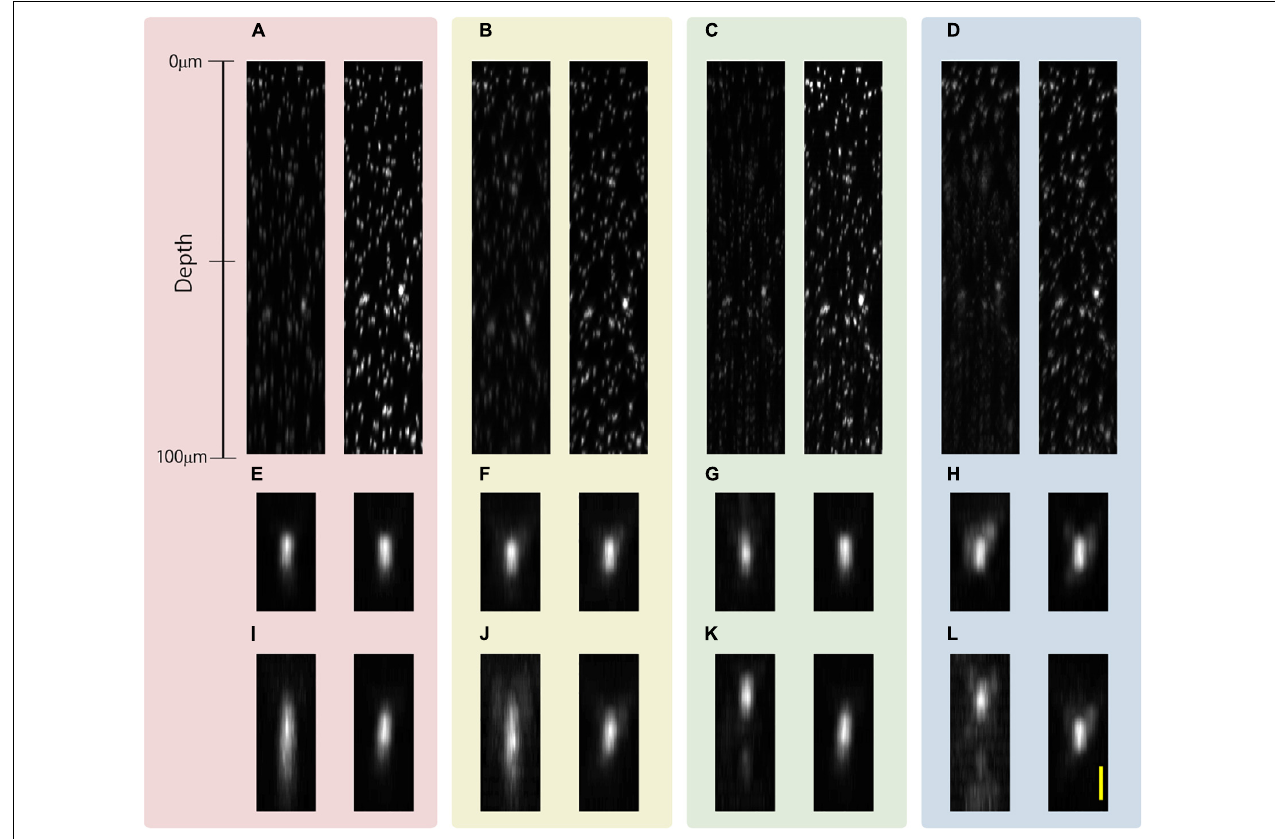
FIGURE 4 | x-z projected images of 500-nm-diameter fluorescent beads in a transparent epoxy resin obtained using the (A) CP, (B) APV, (C) AMCP, and (D) AMAPV excitation beams. Left: without SA correction. Right: with SA correction. (E–H) Magnified view of the observed bead existing near the surface of the epoxy resin. (I–L) Magnified view of the observed bead existing at an optical depth of approximately 80 µ m. Scale bar: 1000 nm.